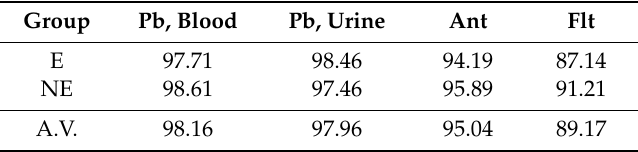
Table 12. Ratio (%) between the estimated contaminant concentration in blood or urine due to the diet route only and total concentration estimated by MERLIN. E = exposed, NE = non exposed.